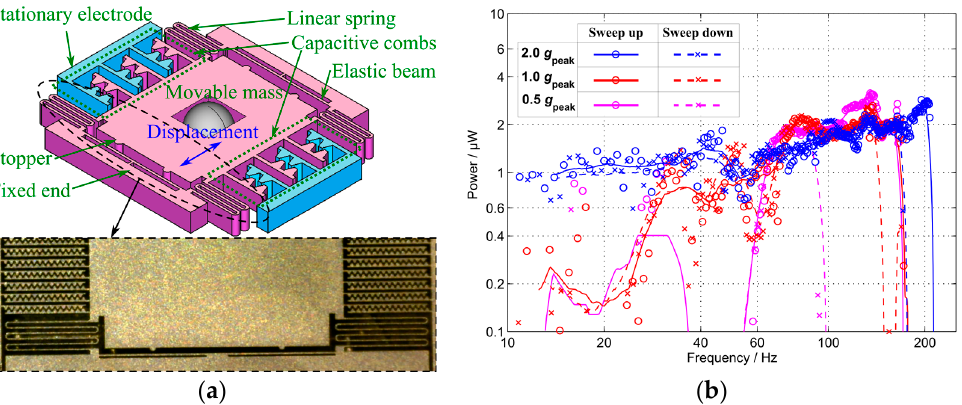
Figure 2. The power supply module: ( a ) Simplified schematic and microscopic photograph of the MEMS-based VEH working as the power supply; ( b ) Transduced power of the VEH with frequency sweeps in air, working with the optimal load resistor R = 6.6 M Ω and a bias voltage of 20